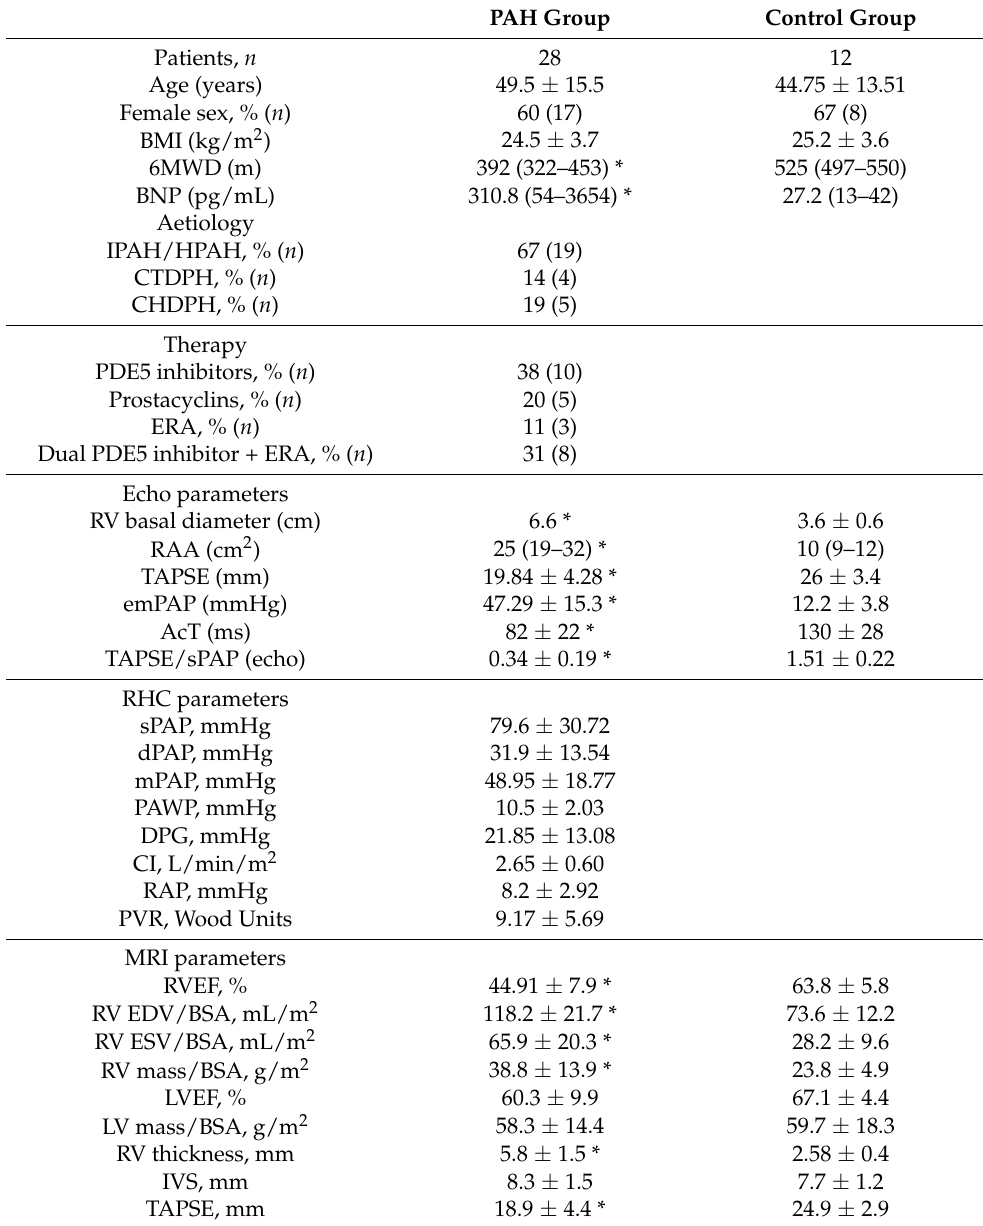
Table 1. General characteristics of pulmonary arterial hypertension (PAH) patients and control